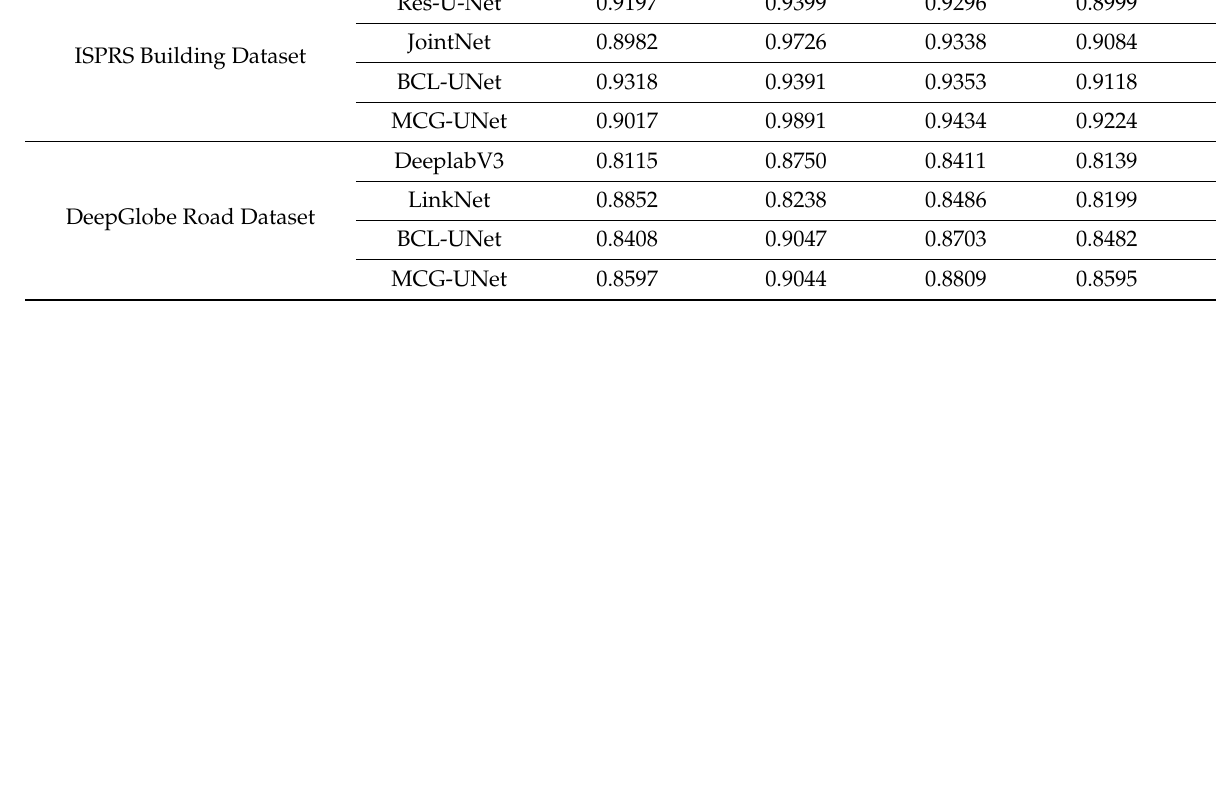
Figure 11. Building map comparisons produced by the presented BCL-UNet and MCG-UNet techniques against other deep learning-based networks. The yellow boxes present the predicted FPs and FNs. Table 6. Quantitative results generated by BCL-UNet and MCG-UNet for road and building extraction from other datasets. Methods Recall Precision F1 MCC